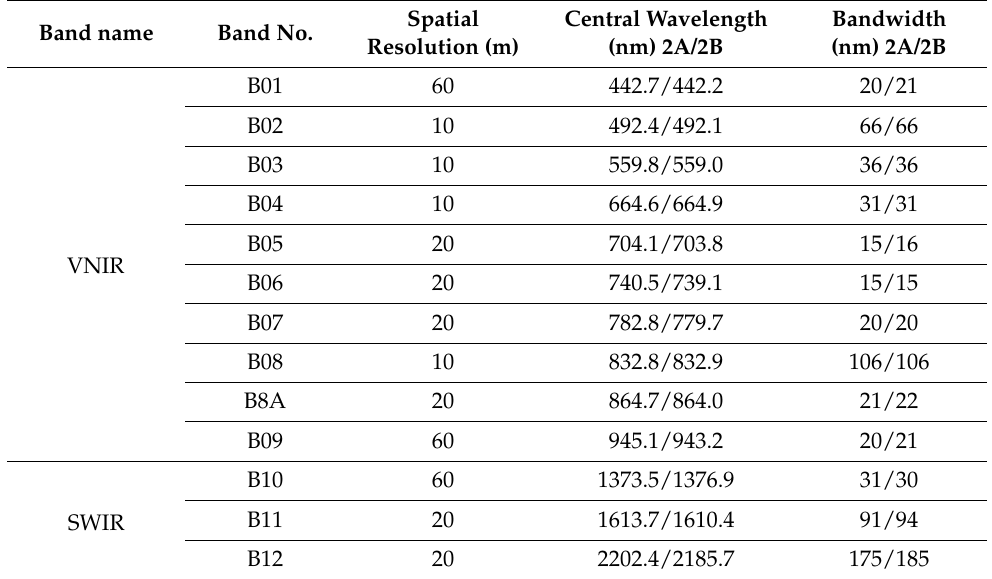
Table 1. Sentinel-2 spatial resolution, central wavelength, and bandwidth for each of the VNIR and SWIR bands. Band name Band